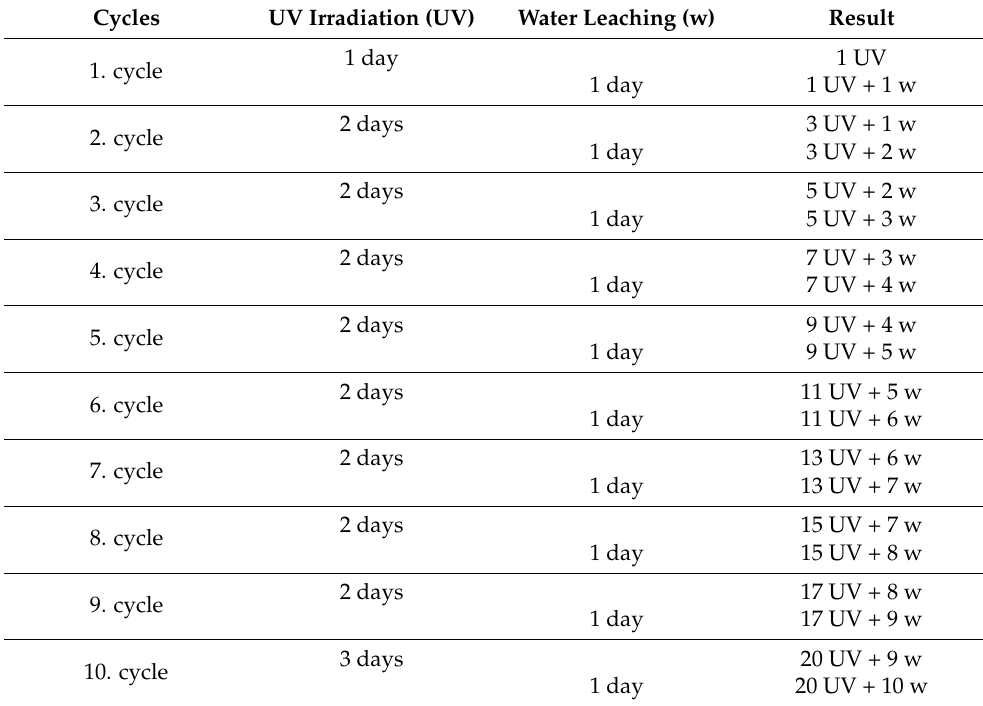
Table 1. The order of UV irradiation and water leaching during the treatment. Cycles UV Irradiation (UV) Water Leaching (w)